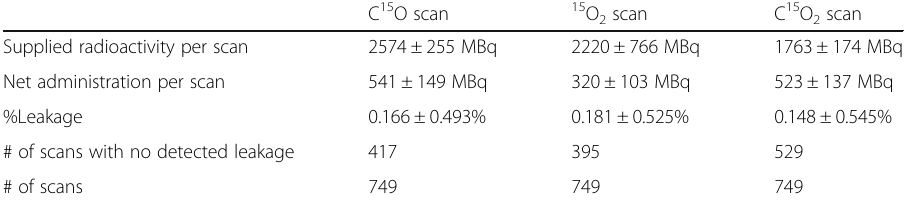
Table 3 Summary of the supply and net administration doses, and the leakage from the face mask system